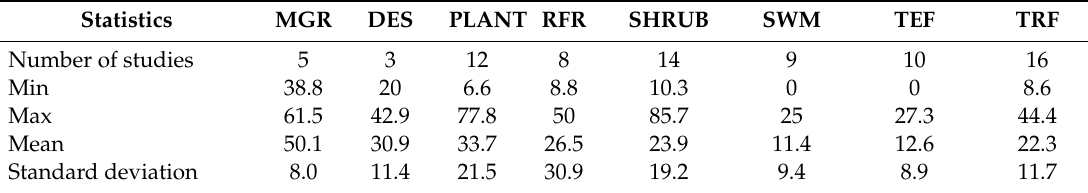
Table 5. Synopsis of the percentage (and dispersion measures) of venomous species within snake assemblages across habitats, on the basis of the selected studies. Statistics MGR DES